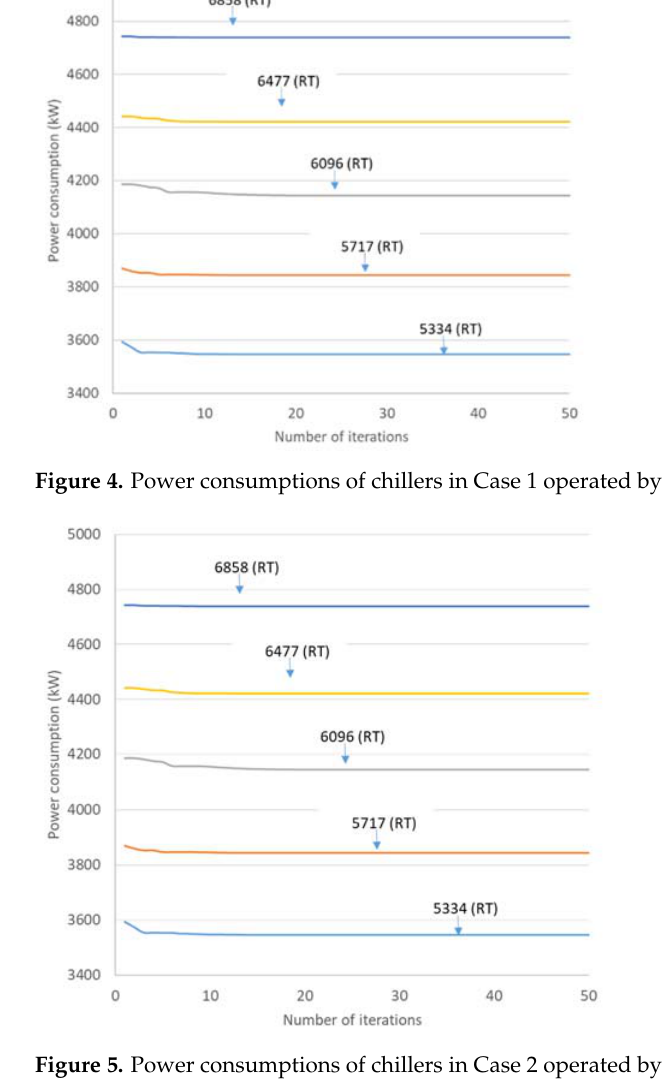
Figure 6. Power consumptions of chillers in Case 3 operated by TPSO algorithm. 4.3. Compare the TPSO Algorithm with Other Algorithms To verify the effectiveness of the TPSO algorithm as the best solution, three case stud- ies are adopted to compare the results of the proposed algorithm with original particle swarm optimization and other recently published algorithms, DE [9], DCEDA [20], EIWO [22] and IFOA [18]. The compared results for Case 1, Case 2, and Case 3 are shown in Tables 13–15, respectively. In these three case studies, the results generated by using TPSO algorithm are the same with those by other algorithms. In Case 1, the compared algorithms are original PSO [22], DCEDA [20], EIWO [22] and IFOA [18] as shown on Table 13; In Case 2 and Case 3 the original PSO [3], DE [9], EIWO [22] and IFOA [18] are compared, as shown on Tables 14 and 15, respectively. In Case 1 under 5717 RT and 5334 RT cooling load, the results generated by using the TPSO are lower than those by the original PSO in the amounts of 63.35 and 79.33 kW, respectively. The comparison indicated that the TPSO algorithm out- performed the original PSO algorithm and all other algorithms presented in this paper.